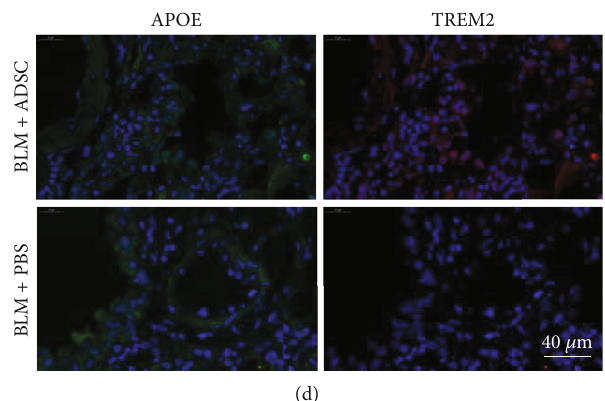
Figure 3: ADSC injection changed composition of macrophage population in BLM-treated lung. (a) UMAP distribution of 9 monocyte/ macrophage clusters in lung-originated cells, merging the BLM + ADSCs group and BLM + PBS group. (b) Stacked violin plot of cluster marker genes (top three marker genes for each cluster) and cell count of monocyte/macrophage clusters. (c) REACTOME pathway analysis of marker genes of Mo/Ma-1 and macrophage-4 clusters. Genes are fi ltered by a condition of log2 fold change > 0.5 and adjusted P value < 0.1. (d) Immuno fl uorescence images of APOE and TREM2 which the highly expression genes in macrophage-4 on day 7 post BLM